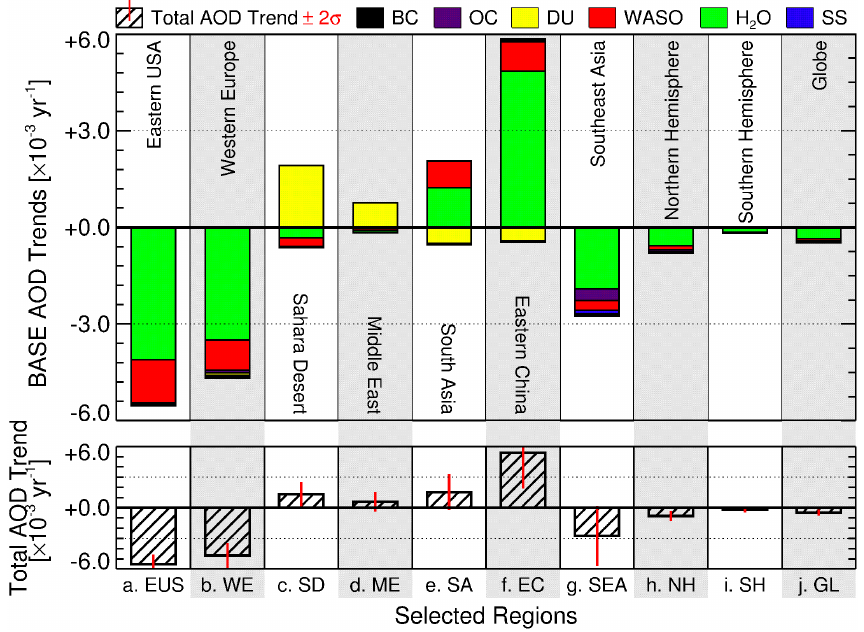
Figure 7. AOD changes between 2001 and 2010 for different regions and species calculated from model results of simulation BASE. The error bars depict 2 standard